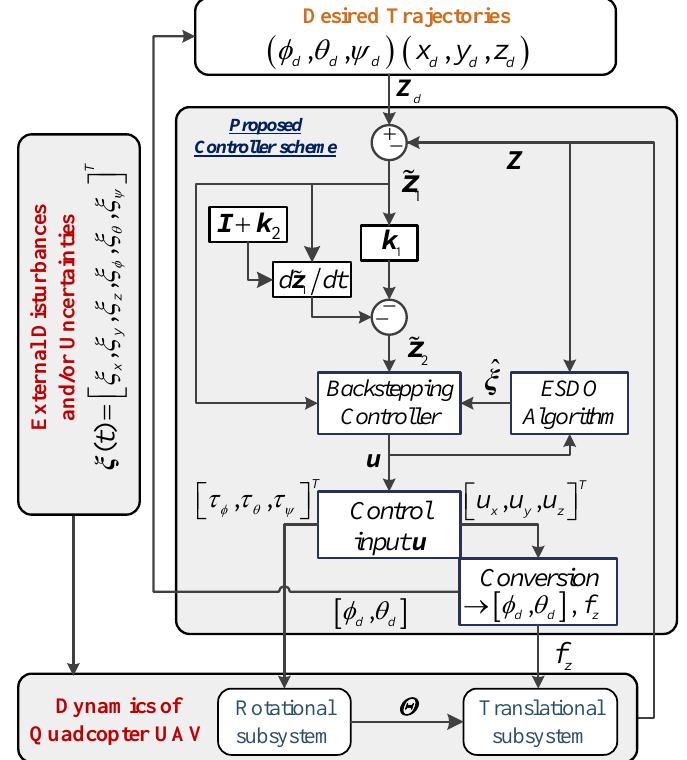
Figure 2. General scheme of UAV’s control system.